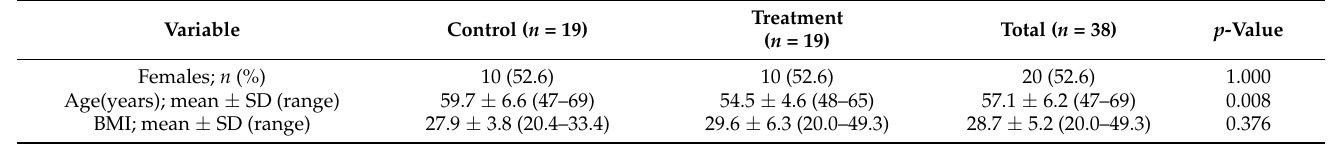
Table 1. Characteristics of the sample, by group.